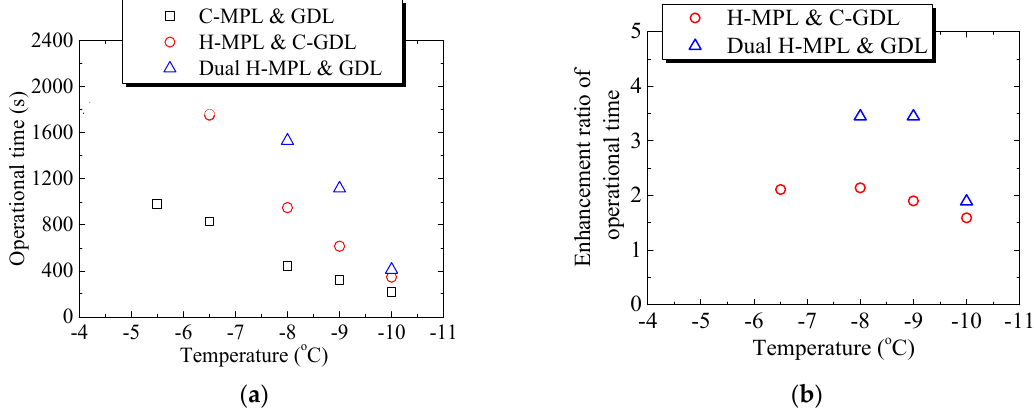
Figure 13. Effect of different structures on the PEMFC operation time at different below-freezing temperatures: ( a ) Relationship between low-temperature start temperature and operation time of PEMFC with different structures of MPL/GDL; ( b ) The relation between the enhancement ratio of operational time and temperature.